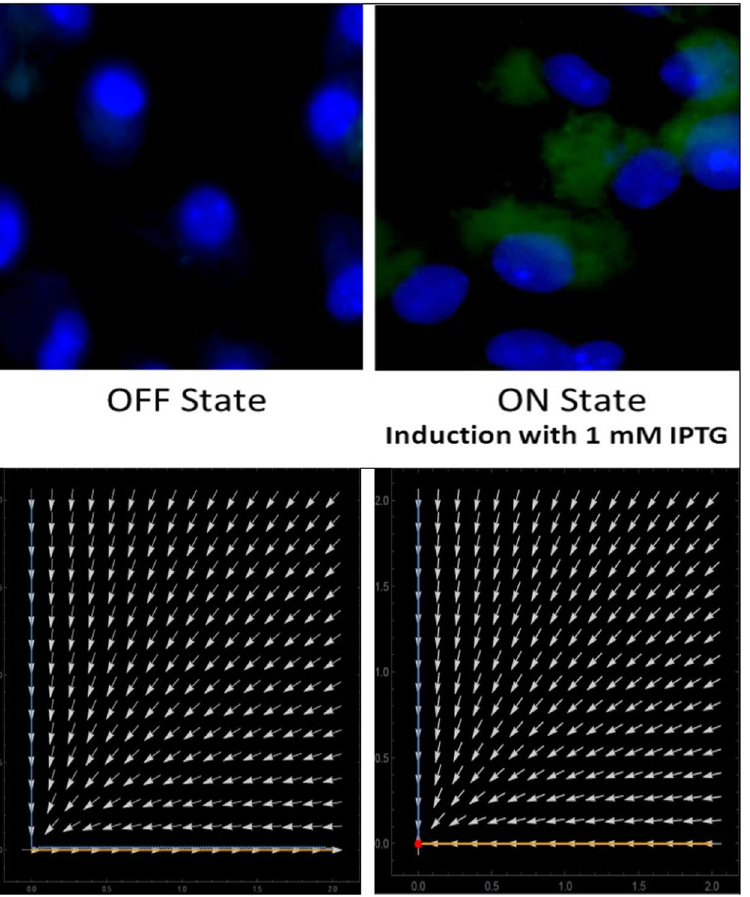
Figure 5. The ON and OFF working of the circuit measured as a function of GFP expression on induction with IPTG: Upper panel shows the OFF (no GFP expression) and ON (GFP expression in the presence of inducer IPTG) state in transfected peritoneal macrophages; Lower panel shows the phase plane diagram explaining the convergence of the system to the ON